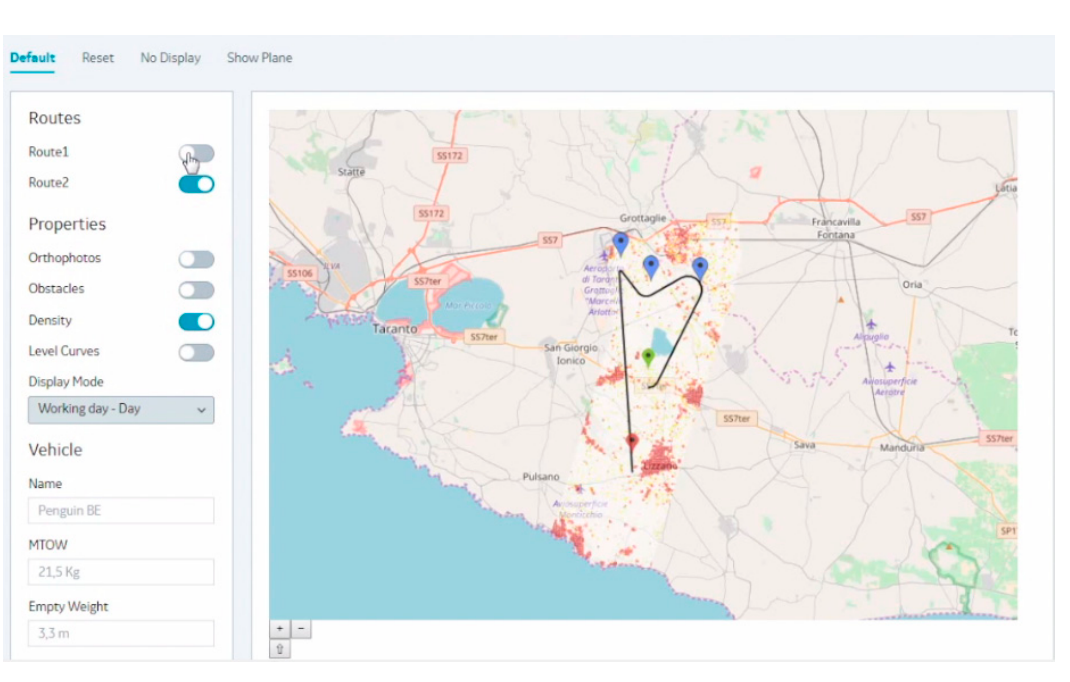
Table 2. Aircraft data for sample mission.